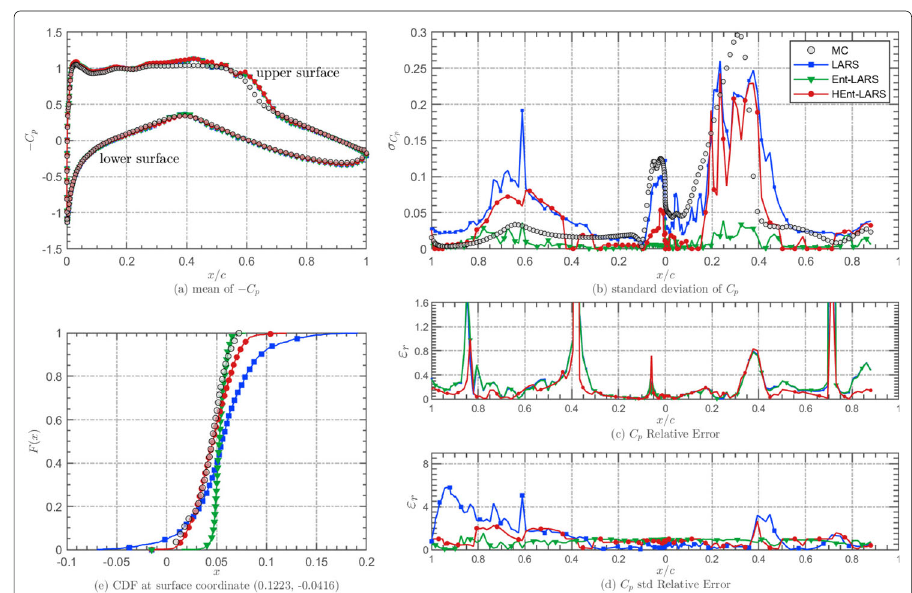
Fig. 15 Performance comparison of LARS, Ent-LARS and HEnt-LARS w.r.t. the RAE2822 airfoil